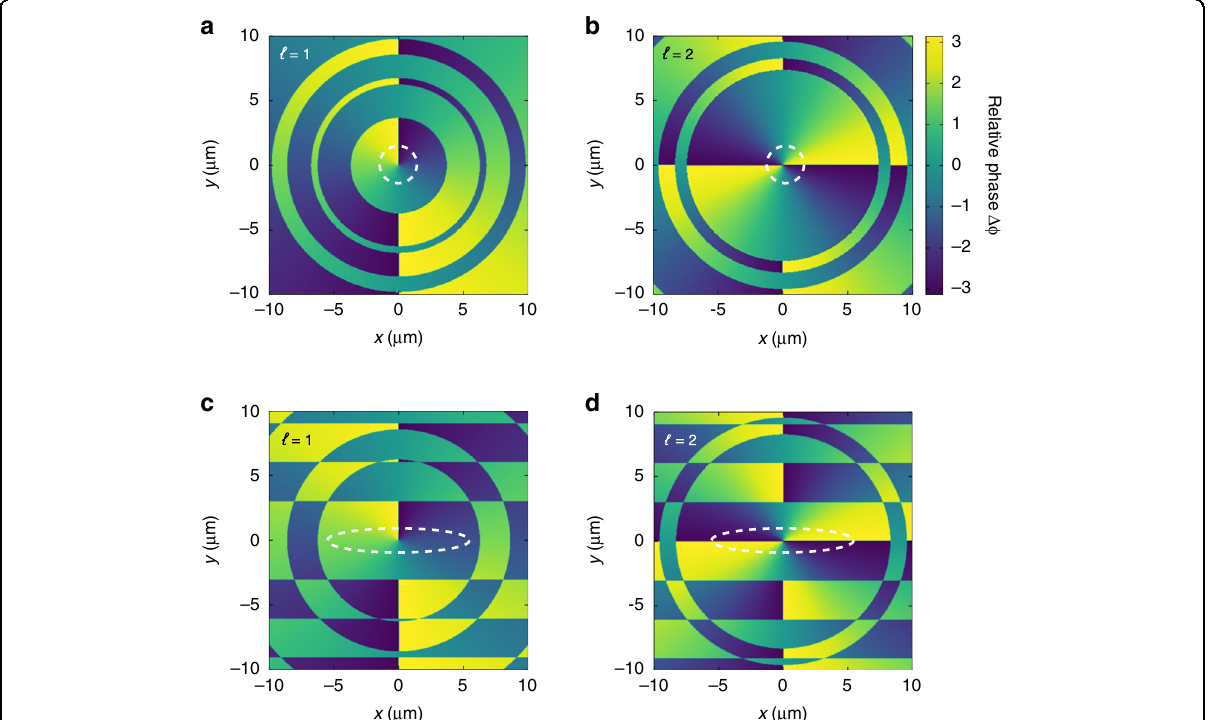
Fig. 3 Relative phase distributions of the two-color light fi elds in focal plane. a , b The spatial structure of the two-color fi eld is not sculptured. c , d The probing light in the two-color fi eld is sculptured by a 2-mm horizontal slit. The OAM modes of the unknown fi elds are ℓ = 1 ( a , c ) and ℓ = 2 ( b , d ). The dashed lines encircle the regions where the photoionization rate is